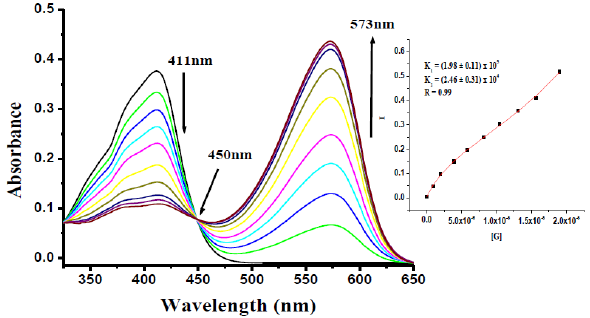
10-5 M) upon 10-4 M)